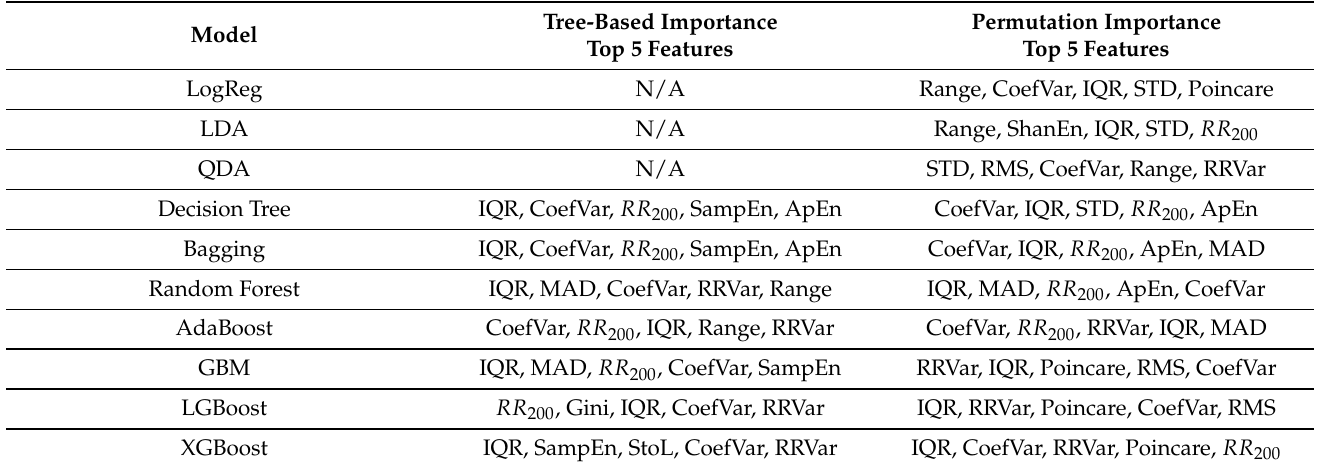
Table 6. Top five features for all models with the 5-s segmentation scheme.